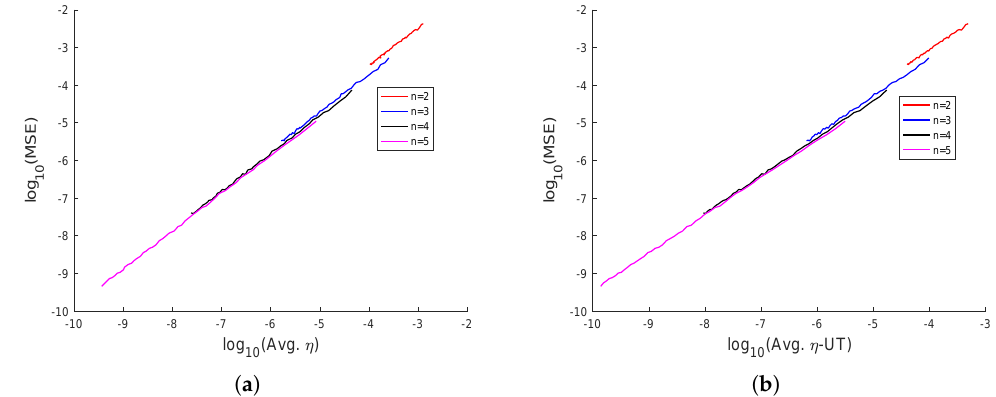
Figure 18. log (MSE) vs. logarithm of MoN of Straka et al. ( a ) log 10 log (MSE) vs. log (Avg. η -UT) using 10 scalar 10 10